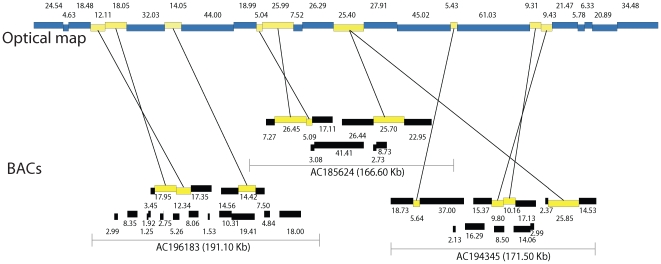
Alignment of unfinished BAC sequence contigs to optical contig maps.Matching restriction fragments in the BAC sub-contigs and the optical contig map are indicated by yellow boxes connected by lines; numbers show fragment size (kb). These alignments illustrate how BAC sequence contigs can be ordered and oriented using optical map alignments.